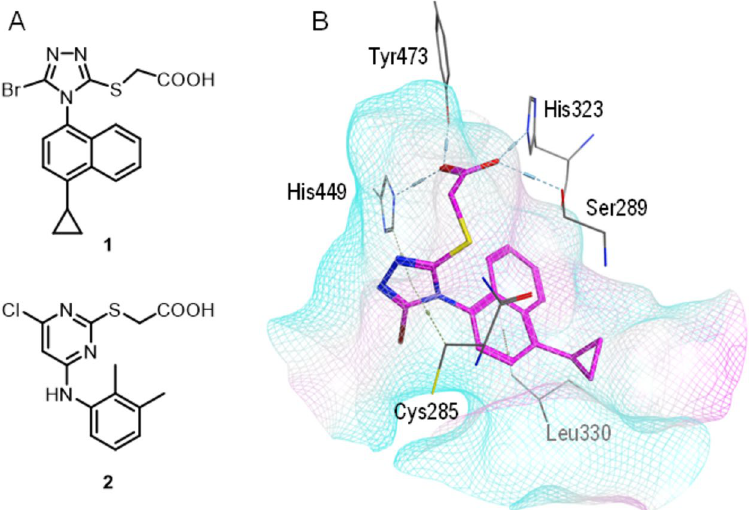
Figure 1. ( A ) Lesinurad ( 1 ) structurally resembles the dual PPAR α /PPAR γ agonist WY14,643 ( 2 ) and shares the typical architecture of fatty acid mimetics. ( B ) Molecular docking of lesinurad ( 1 ) into the PPAR γ ligand binding domain (PDB-ID: 3ET3 17 ) suggests a very favorable binding mode. The carboxylic acid of 1 forms neutralizing contacts with the triad of Ser 289 , His 323 , His 449 and Tyr 473 and the triazole moiety participates in π -interactions with Cys 285 and His 449 . Lesinurad’s hydrophobic tail is placed in a lipophilic arm of the PPAR ligand binding